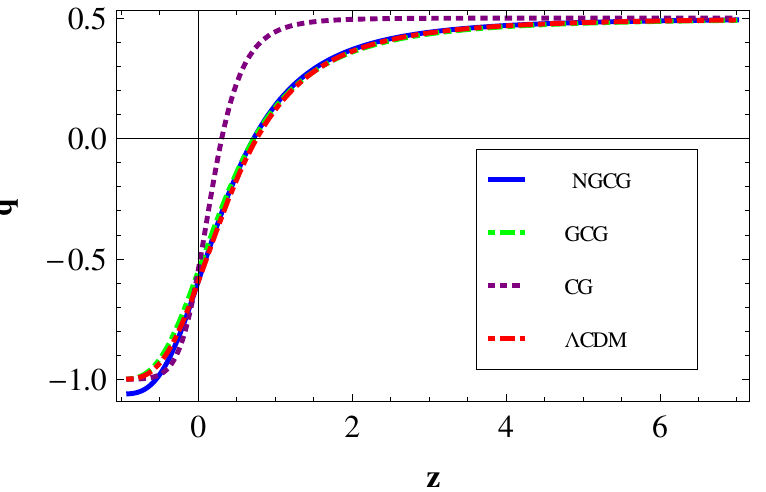
Figure 3. Plot of q as a function of z is shown by considering the values of model parameters, as given in Table 1, arising from the joint analysis of H ( z ) + BAO + CMB + BBN + SNIa (Pantheon) dataset (blue curve). Here, the red, green, and dotted (purple) curves represent the corresponding evolution of q in a standard Λ CDM, GCG, and CG models,